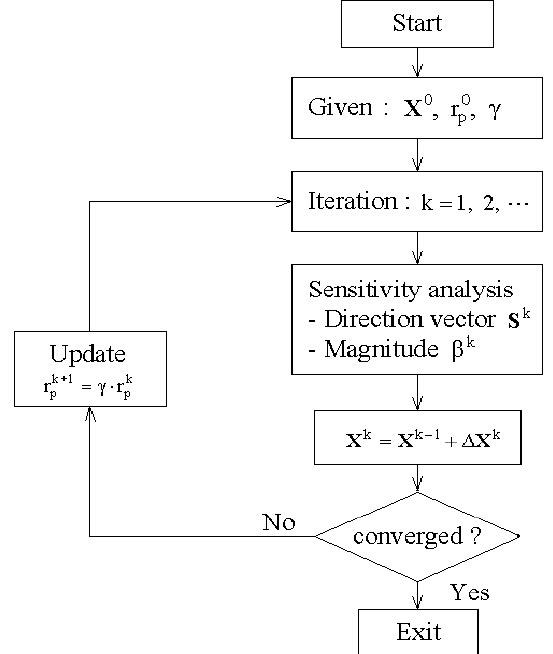
Figure 4. A flowchart of the CNT distribution optimization.